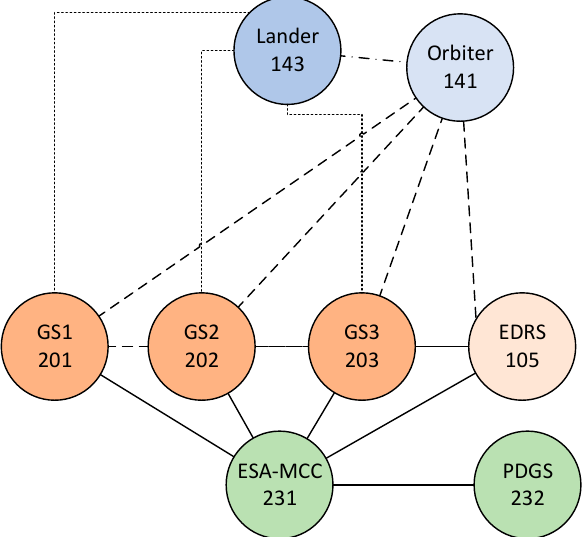
Figure 4. Layout of the Mars–Earth network considered in the paper. Dotted/dashed lines: space intermittent links, with LTP; continuous lines: terrestrial continuous links with TCP.